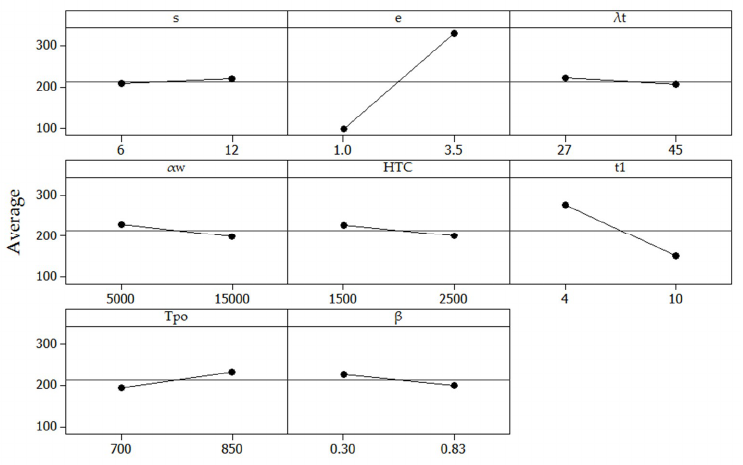
Figure 6. Main effect chart for Tipt110 .